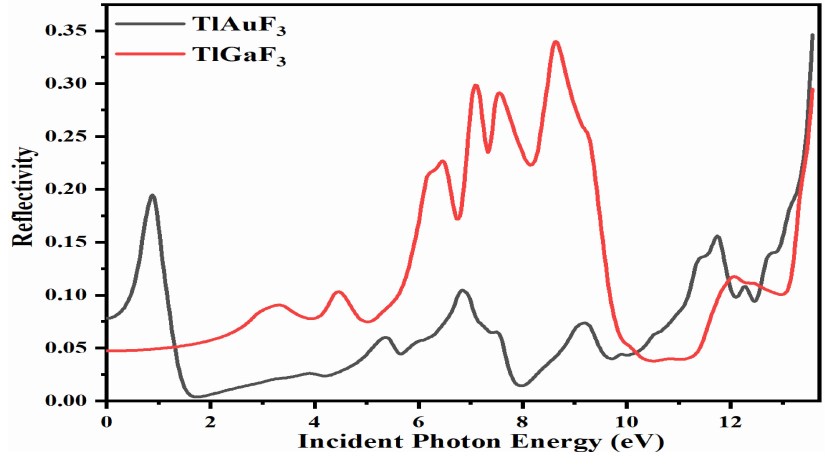
Figure 8. Calculated reflectivity coefficient R( ω ) for compounds TlMF 3 (M = Au,